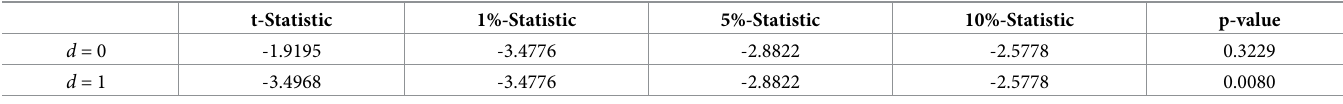
Table 2. ADF test of monthly cases number of hepatitis E.